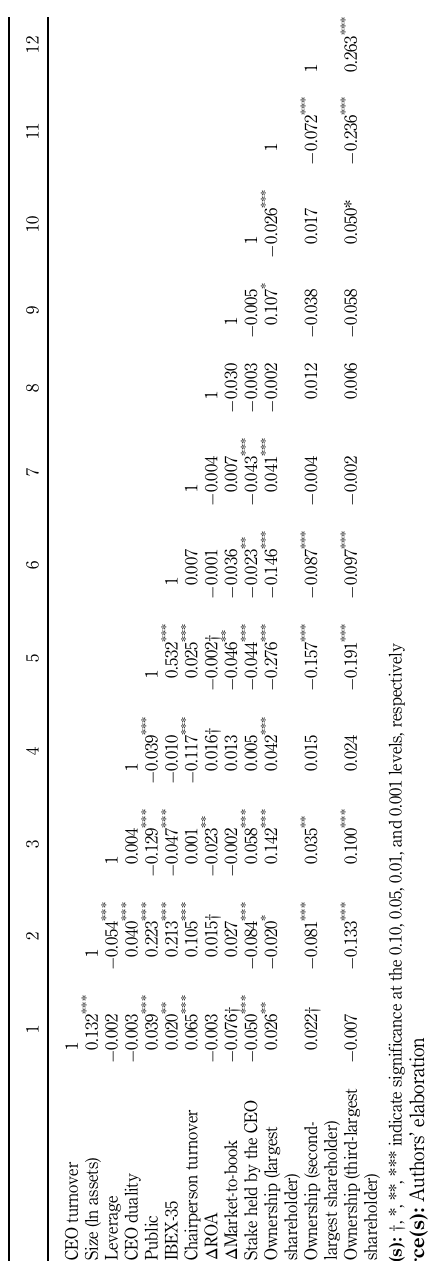
Table A1. Correlation